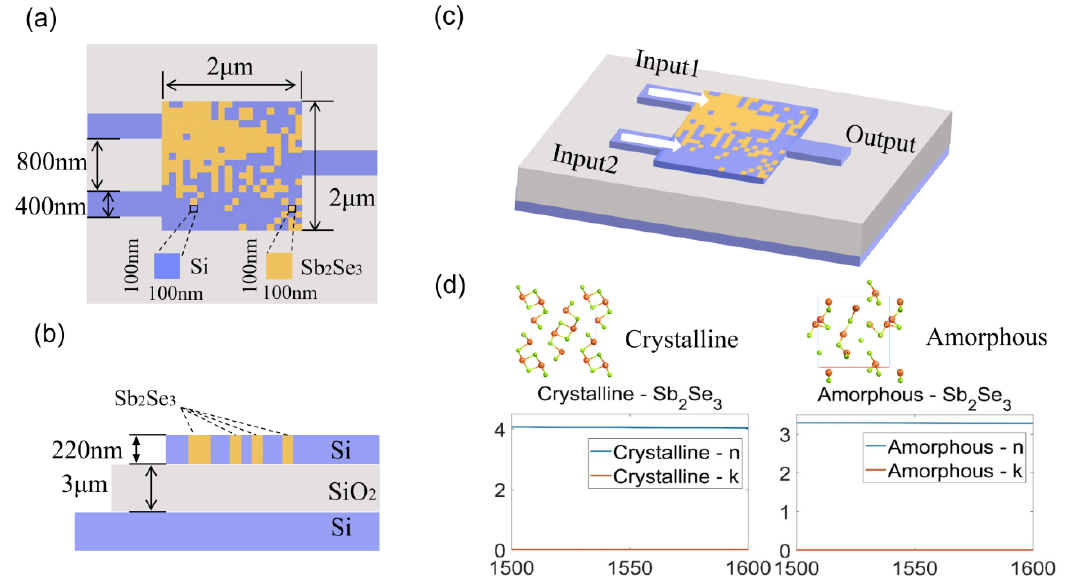
Figure 1. Schematic of the logic gate device. ( a ) Top view of the device; ( b ) Side view of the device; ( c ) Three-dimensional diagram of the device showing two input ports in the left and one output port in the right; ( d ) Atomic distribution and complex refractive index of Sb 2 Se 3 in crystalline and amorphous states.